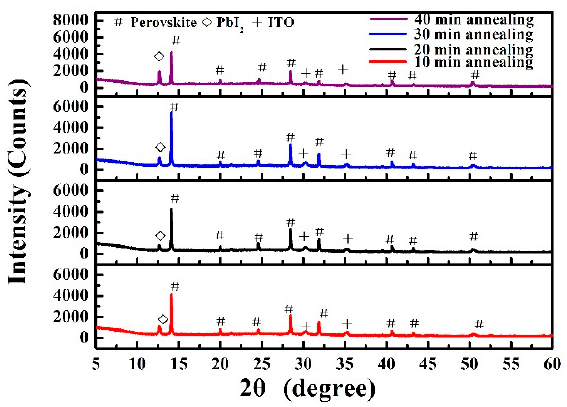
Figure 2. XRD patterns of MA 0.7 FA 0.3 Pb(I 0.9 Br 0.1 ) 3 perovskite films on glass/ITO substrates annealed at ◦ C for 10, 20, 30 or 40 100 °C for 10, 20, 30 or 40 min. at 100